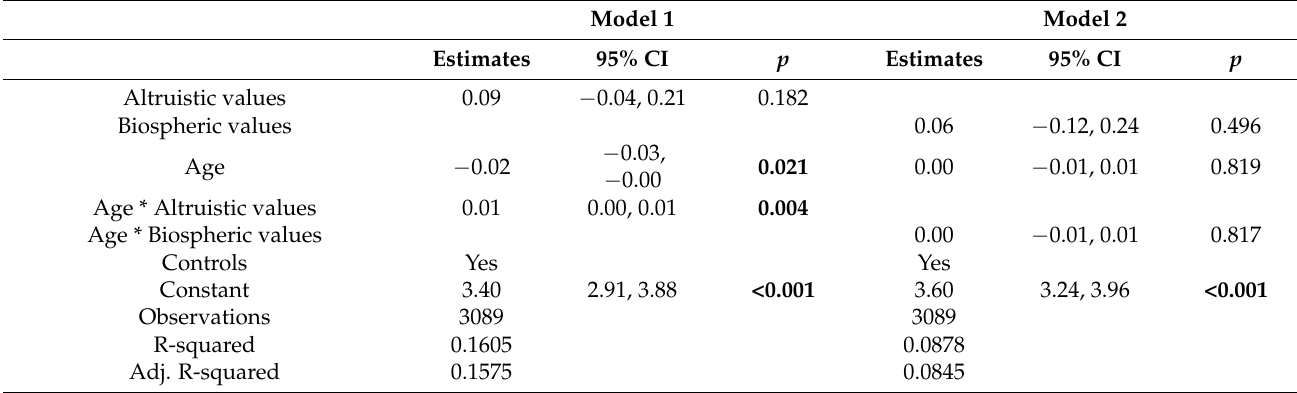
Table 6. Moderating effect of age on the relationship between altruistic values and